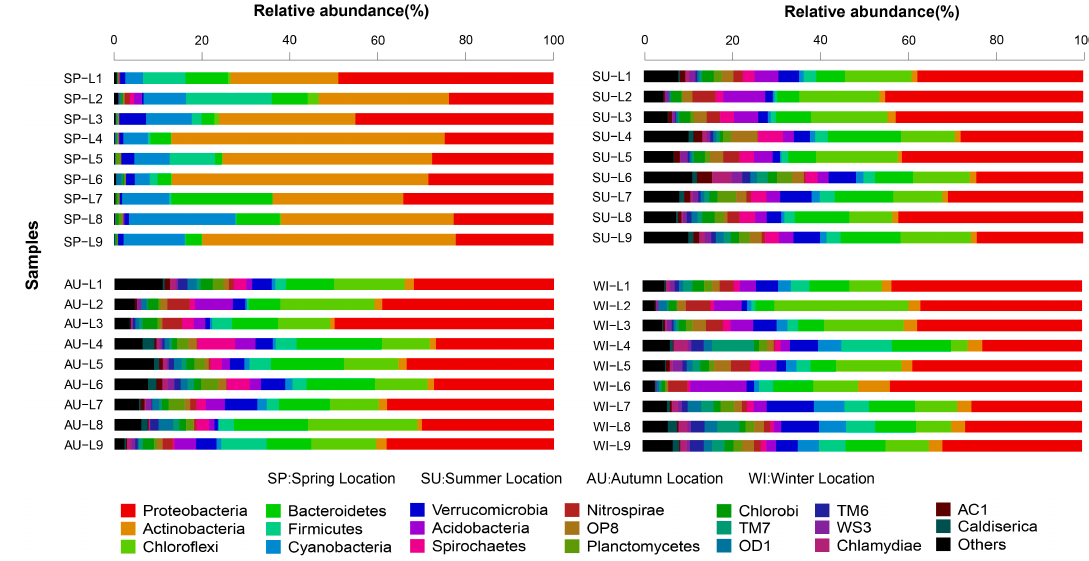
Figure 3. Relative abundance and composition of bacterial phyla detected in sediments of Sancha Lake in the four seasons.